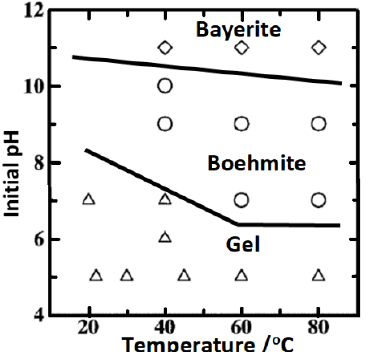
Figure 5 . Initial pH–temperature stability field map of products produced by precipitation method, reproduced with permission by Elsevier from Ref [160]. reproduced with permission by Elsevier from Ref